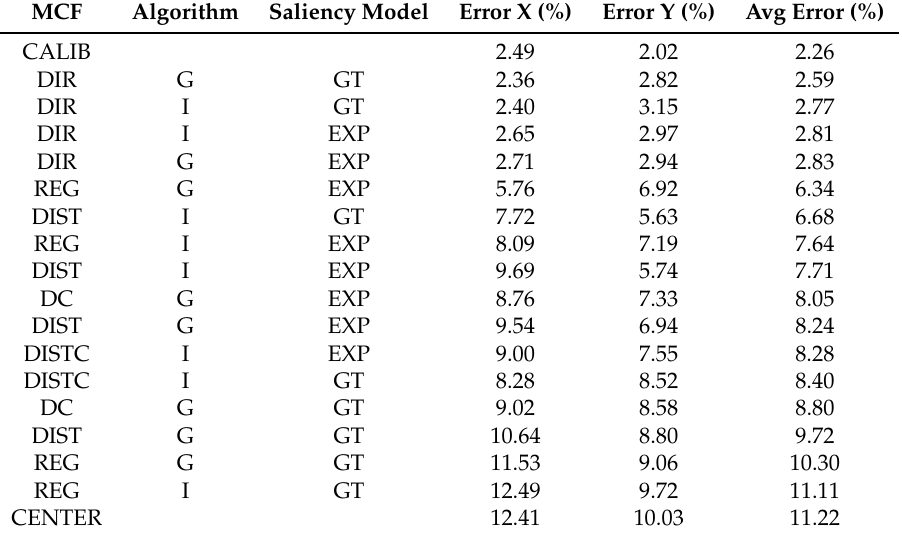
Table 2. Average errors for various MCFs with GT and expert (EXP) saliency models. CALIB stands for classic explicit calibration and CENTER for center target calibration. Algorithm G—genetic optimization, I—incremental